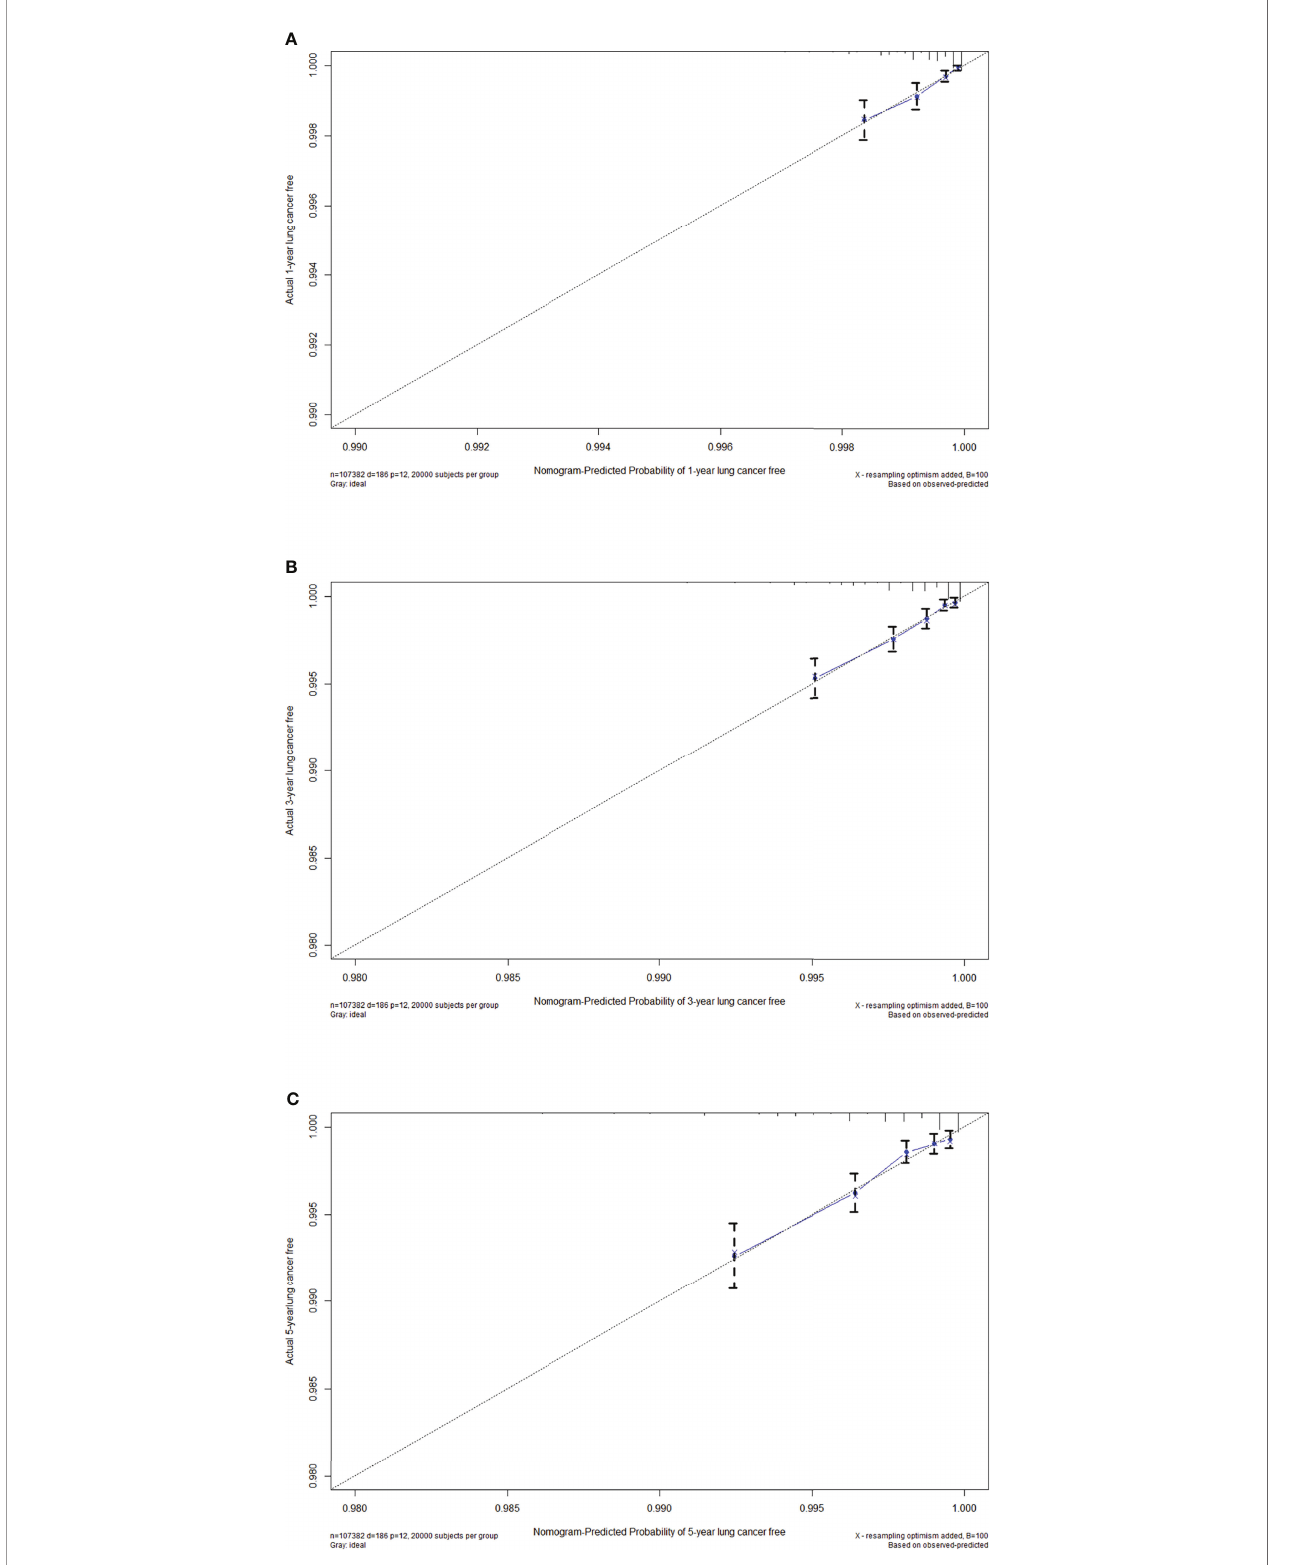
FIGURE 4 | Calibration curves of the nomogram for (A) 1-year, (B) 3-year and (C) 5-year lung cancer free in the training